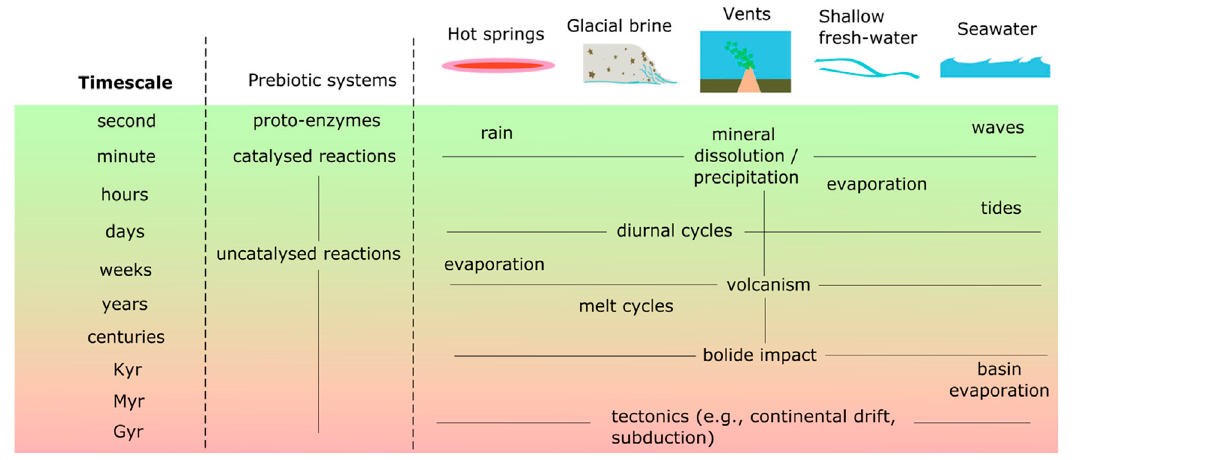
TABLE 2 Timescales of prebiotic chemistry and environmental